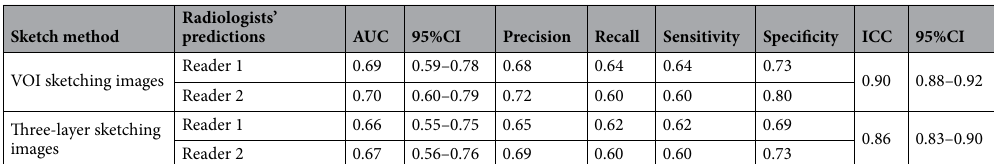
Table 7. Efficacy and stability of physician prediction of the differential diagnosis of primary and secondary ICH based on the two sketching methods. ICC=intraclass correlation